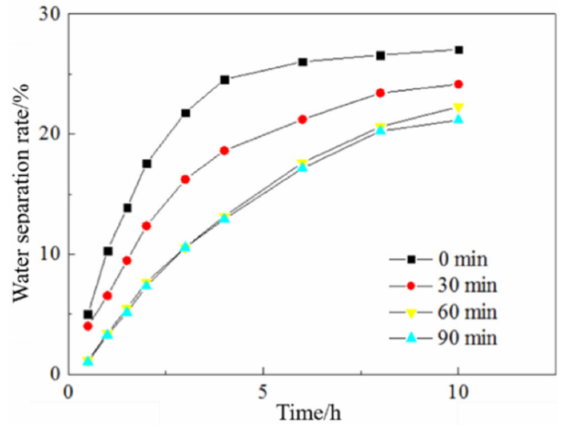
Figure 6. Relationship between the water separation rate and di ff erent emulsification times.